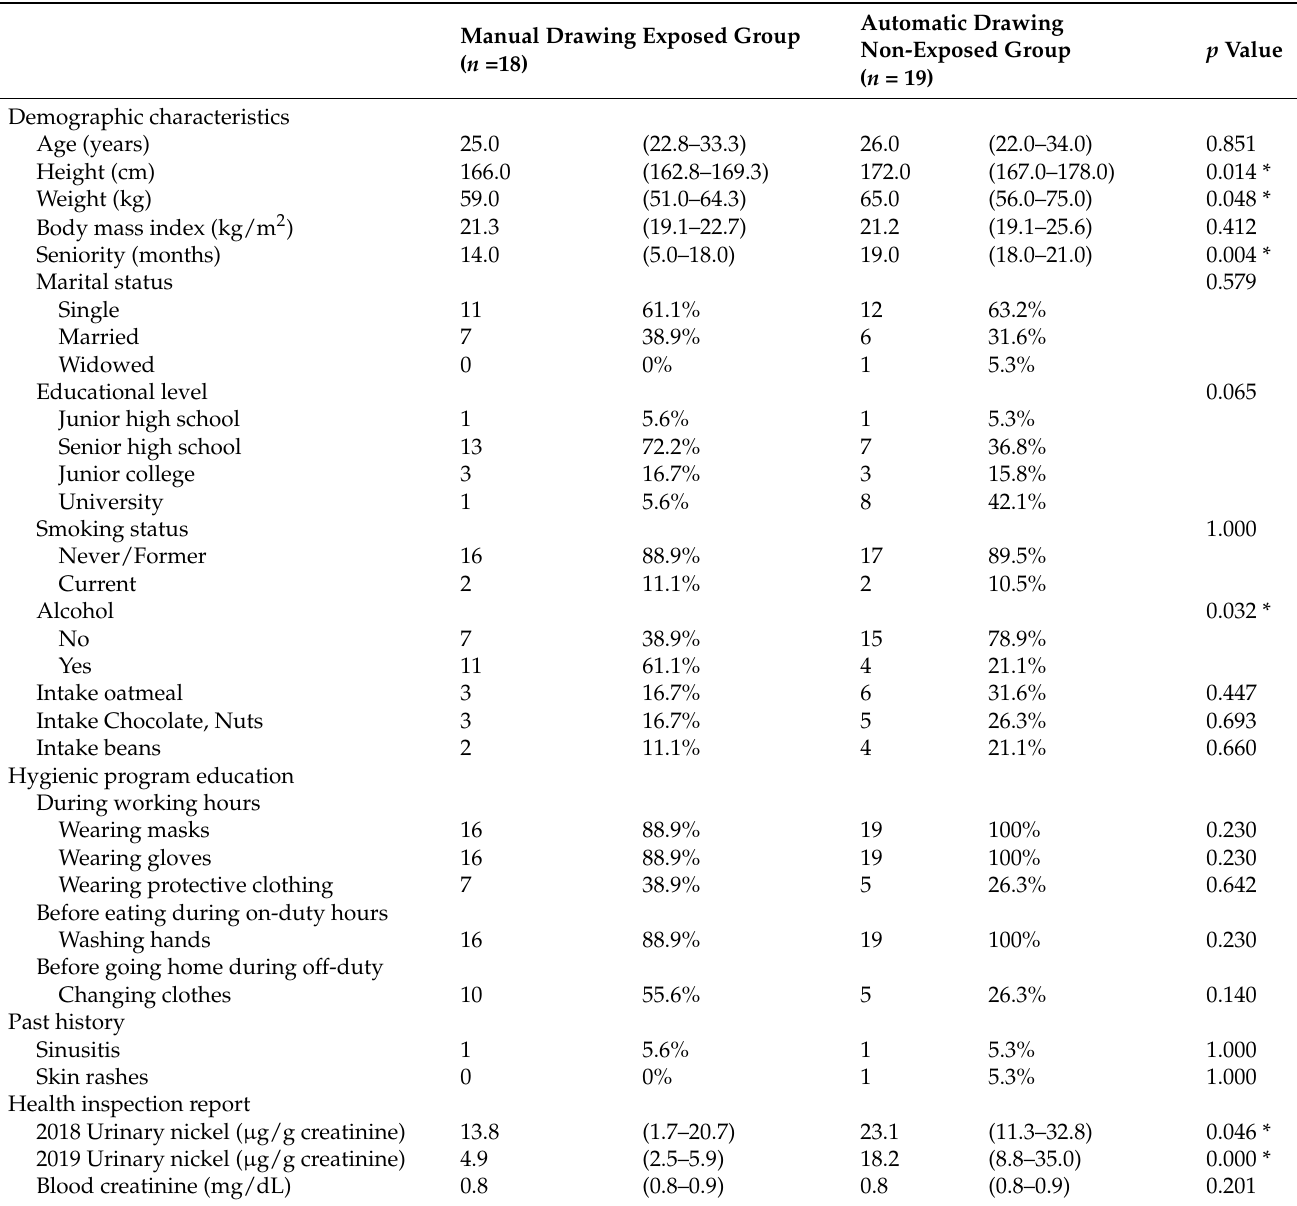
Table 2. Characteristics of participants according to exposure levels to